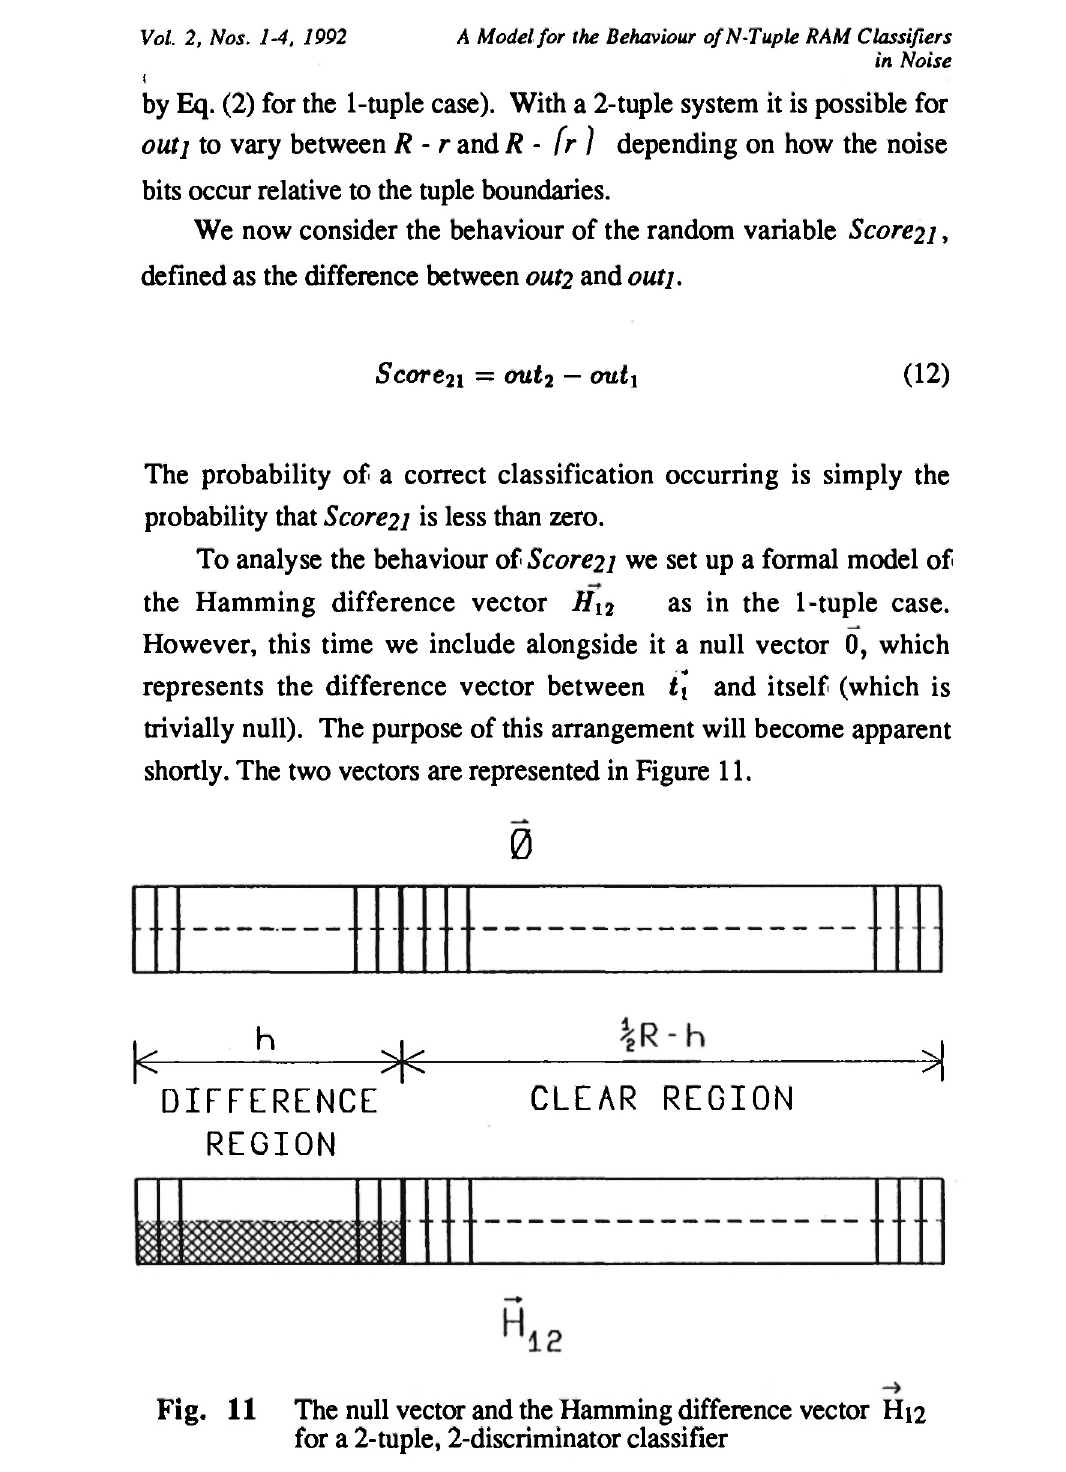
Fig. 11 The null vector and the Hamming difference vector Hi2 for a 2-tuple, 2-discriminator